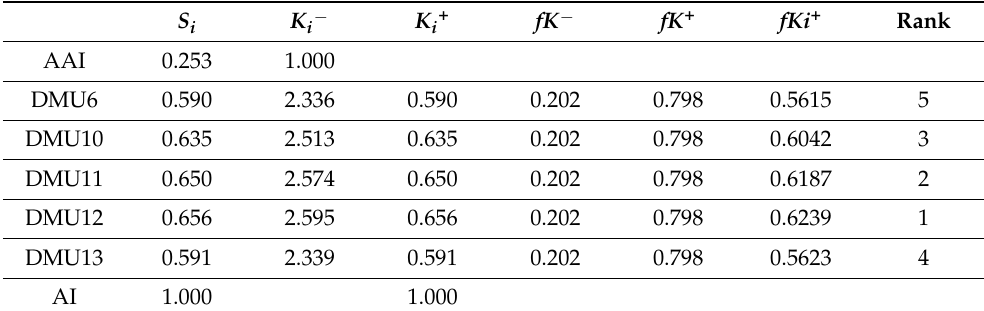
Table 8. Results of applying the MARCOS method–both companies.